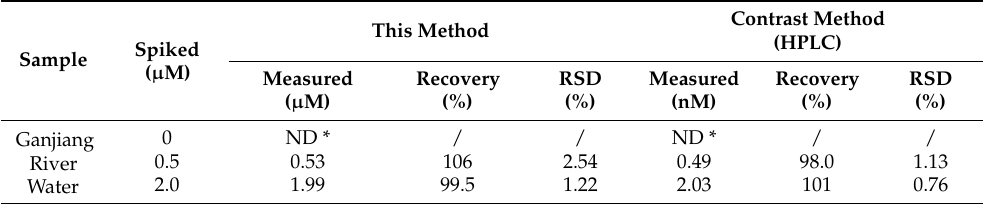
Table 1. The detection of TC in Ganjiang river water and the spiked recovery assays ( n = 3). This Method Spiked Sample (µM) Measured Recovery (µM) Ganjiang